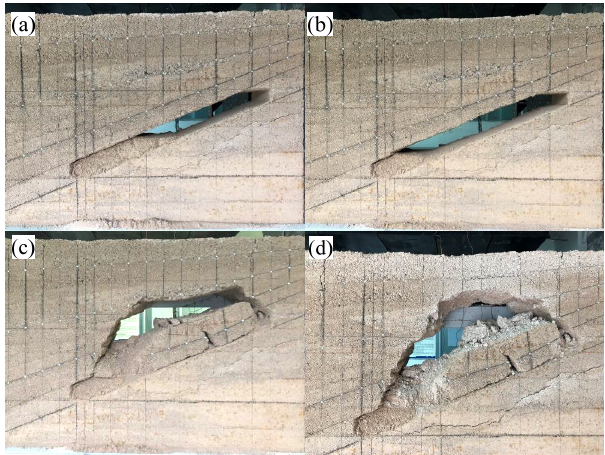
Figure 4. Excavation process of backfill mass: ( a ) Backfill mass excavation to the third sublevel; ( b ) Backfill mass excavation to the second sublevel; ( c ) Overlying strata caving; ( d ) Overlying strata continuous caving.